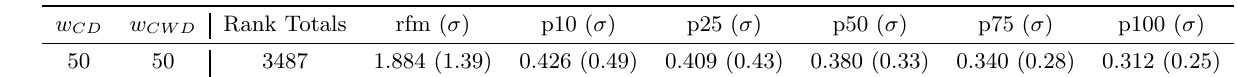
Table 8: Taxis in Rome trace results